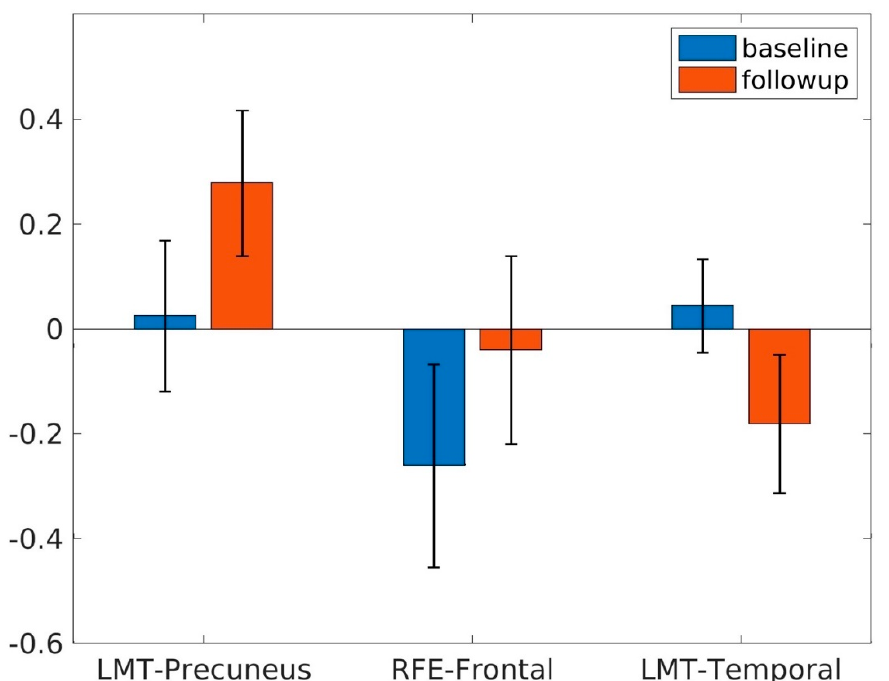
Figure 2. Increased functional connectivity ( a ) in the precuneus area (peak-T at 4, − 52, 52) with the left visual region seed ROI (LMT) and ( b ) in the frontal region (peak-T at (10, 26, 46)) with the right frontal eye field seed ROI (RFE). ( c ) Decreased functional connectivity in the superior temporal area (peak-T at (50, − 20, − 6)) with the left visual region seed ROI (LMT) after 2-month meditation practice at the thresholds of a voxel-level p -value of 0.005 and corrected cluster-level p -value of 0.05. The color bar shows the range of t -values.